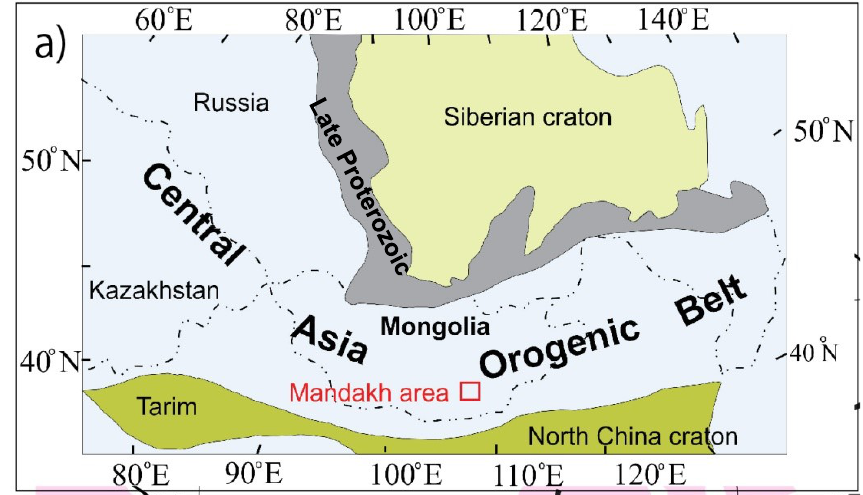
Figure 1. Simplified sketch map of the CAOB showing the main tectonic sub-divisions and location of the Mandakh area (modified after Jahn,